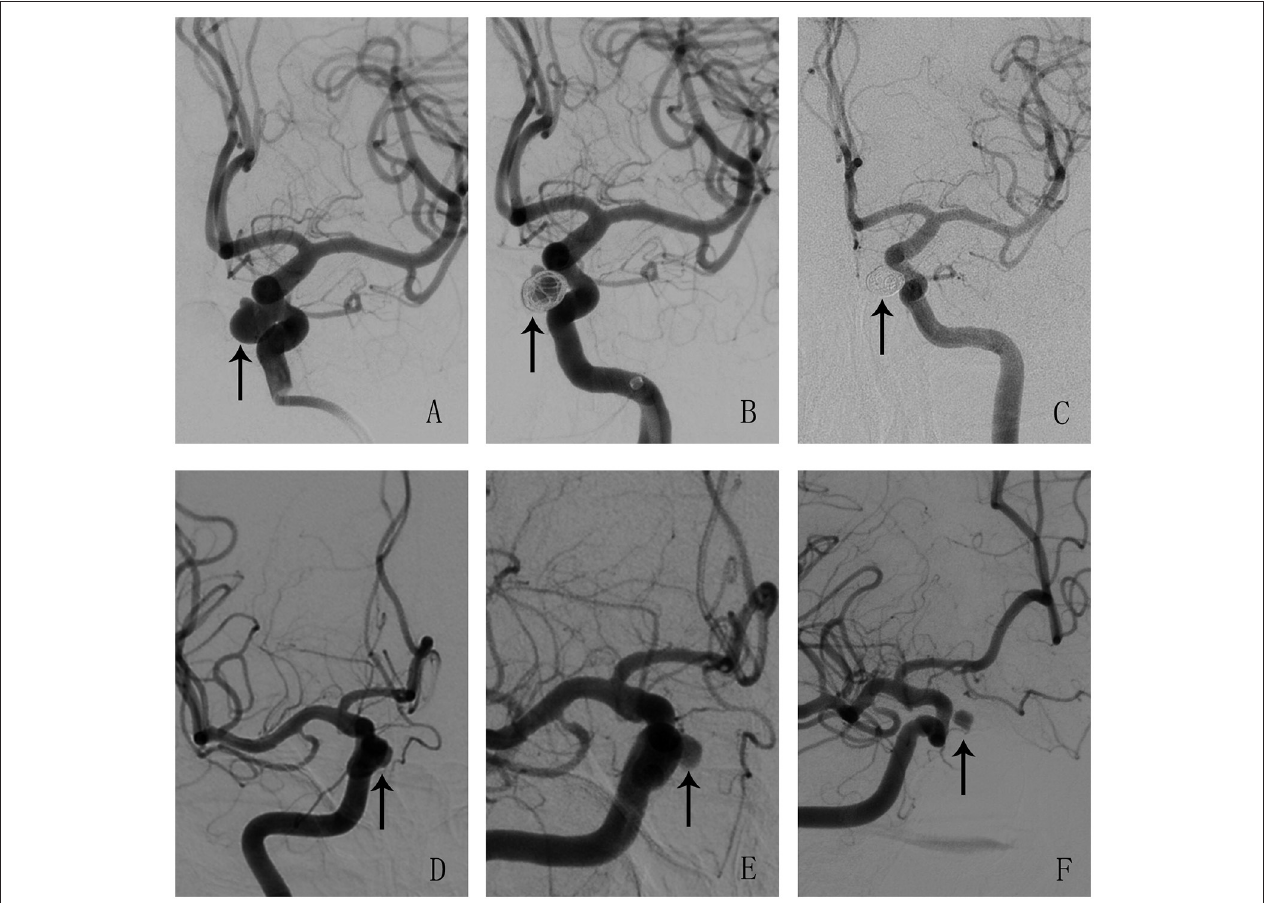
FIGURE 1 | Illustrations of angiographic results in a case treated by pipeline flex embolization device (PED flex) adjunctive with coils ( A–C ) and a case treated by PED flex alone ( D–F ). Aneurysms were pointed out with arrows. ( A–C ) An aneurysm treated by PED + coil at pre-treatment, post-treatment, and follow-up. The angiography results showed that the aneurysm was cured completely after operation at 6 months. ( D–F ) An aneurysm treated by PED flex at pre-treatment, post-treatment, and follow-up. This aneurysm was incompletely occluded and was classified as Raymond III at 6